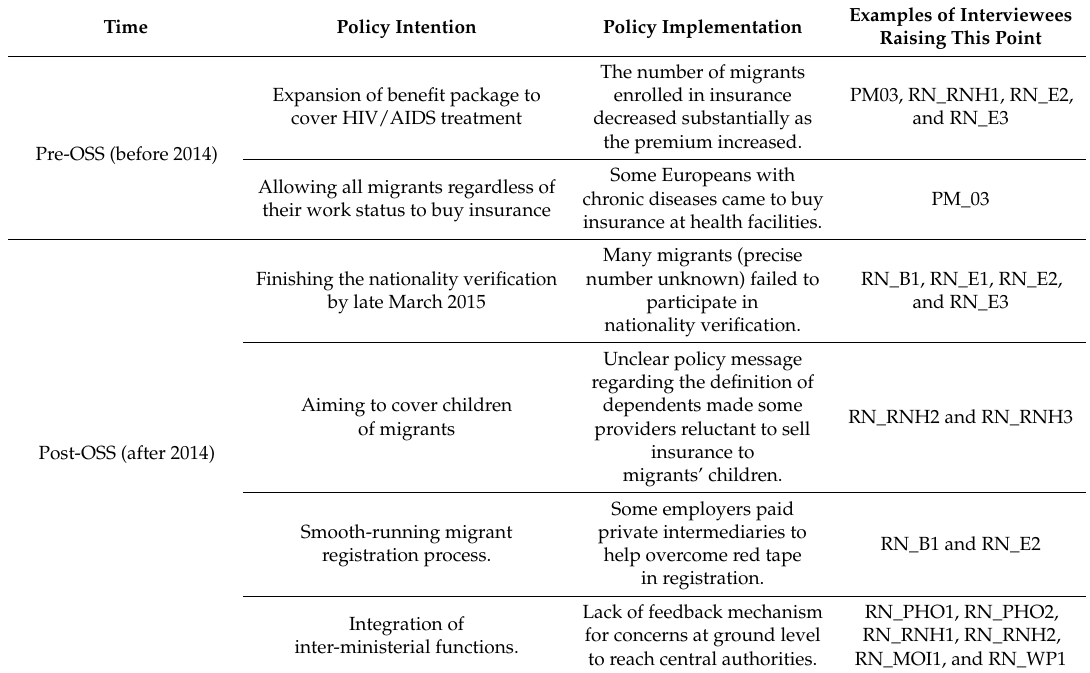
Table 2. Contrasting policy intention and policy